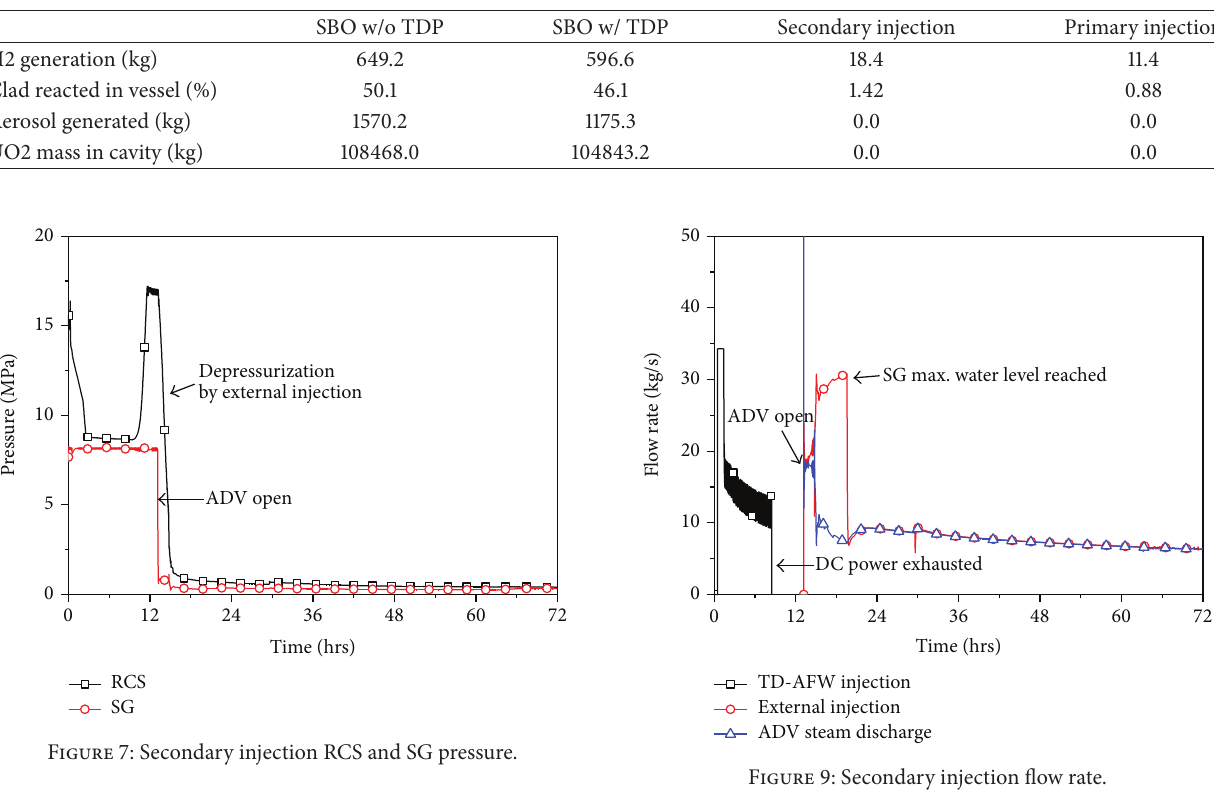
Table 4: Major severe accident progression parameter.